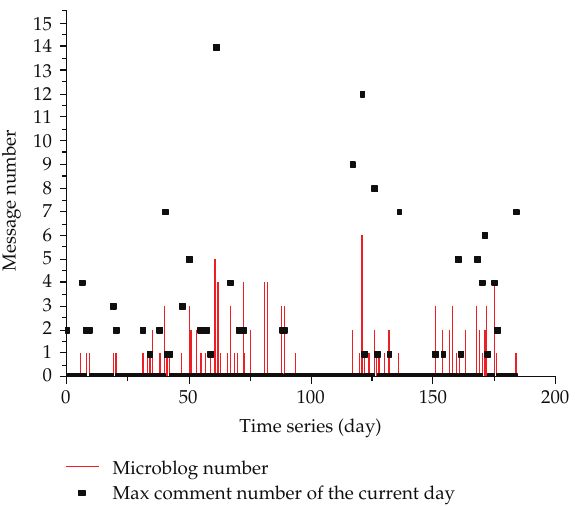
Figure 5: One user’s messaging series sync with S identity